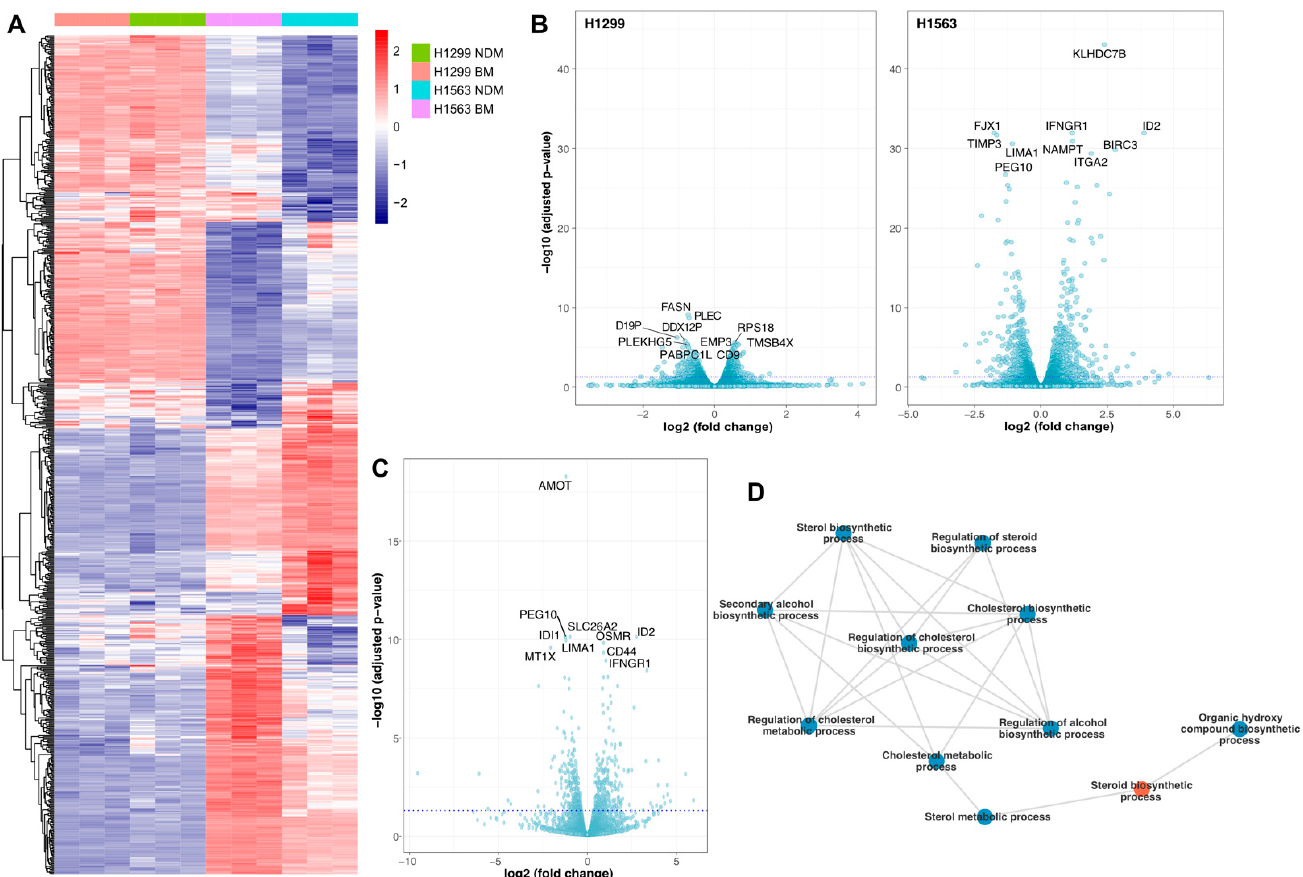
Figure 3. Transcriptome analysis of H1299 and H1563 cells by RNA-sequencing. ( A ) The heatmap shows the normalized read counts for the differentially expressed genes across the four conditions (H1299 in NDM, H1299 in BM, H1563 in NDM, and H1563 in BM) calculated by the interaction term. Data were normalized row-wise to make the expression levels comparable across different genes (color of the heatmap: blue, low expression; red, high expression). The colors above the heatmap indicate cell lines cultured in different media. ( B ) Volcano plots show the differential expression results of the medium effect (in other words, the differences between NDM and BM) in H1299 cells (left) and H1963 cells (right). The x -axis represents the log2 (fold change) values and the y -axis represents the –log10 transformed adjusted p -values. Ten genes with the highest significance (namely, with the lowest adjusted p -values) are labeled. ( C ) This differential expression result reflects how the medium effect differs across H1299 and H1563 cell lines. The volcano plot shows effect-size as log2 fold change of the cell-line-dependent medium effect on the x -axis, and the significance of those differences on the y -axis as − log10 ( p -values). Ten genes with the highest significance (namely, with the lowest adjusted p -values) are labeled. ( D ) A network plot describes interactions of the 64 most significant GO terms based on the DEGs. The result list of GO terms was trimmed to 50% of the original length by REVIGO based on the semantic similarities. The largest cluster of GO terms be- longs to sterol biosynthesis process (red node). The width of the links between the nodes represent the functional similarities calculated by the genetic overlap between nodes. BM, basal medium; NDM, neutrophil degranulation medium.